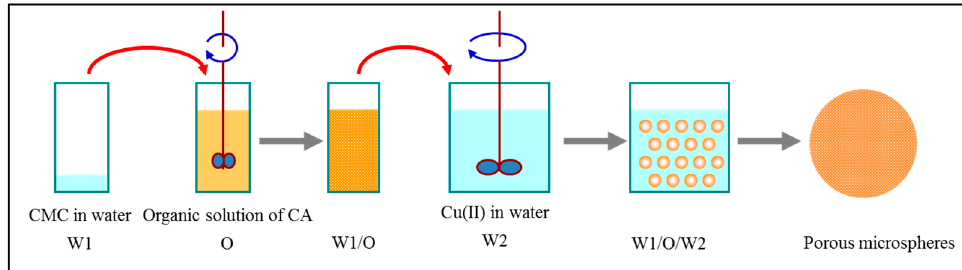
Figure 1. Synthesis pathway of CMC/CA microspheres.